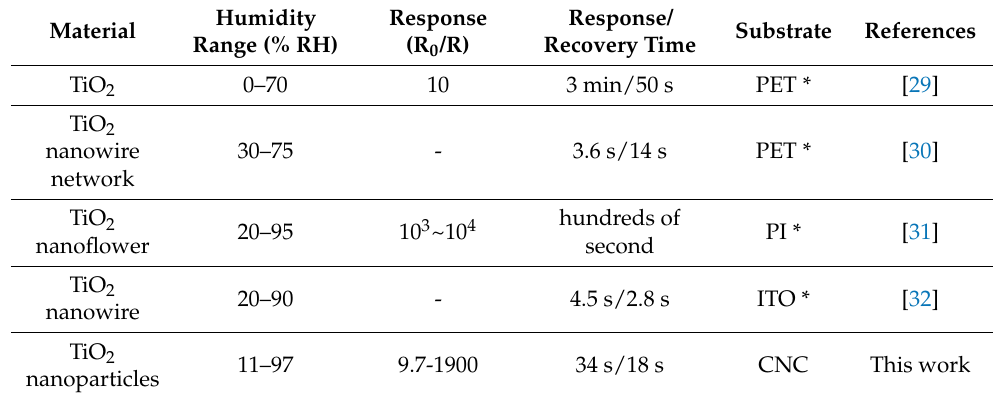
Table 1. Comparison of different flexible humidity sensor based on TiO 2